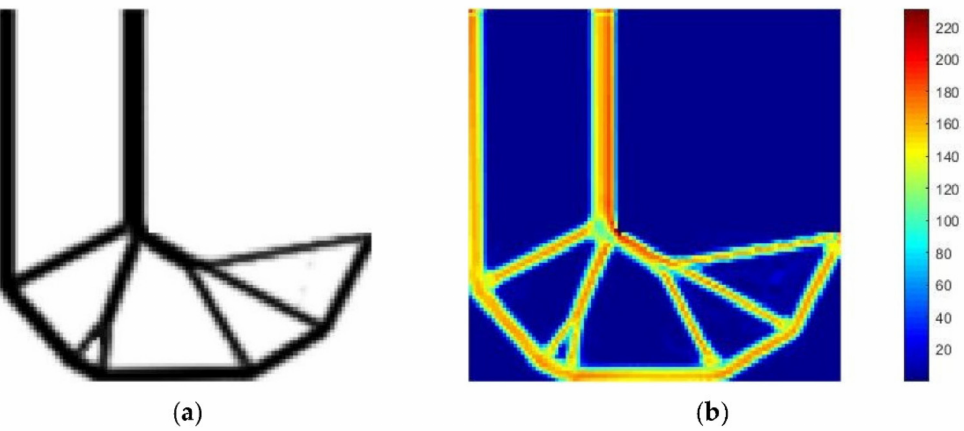
Figure 7. Deterministic topology optimization result of L-beam structure (14,400 elements): ( a ) Topo- logical structure; ( b ) Von Mises stress distribution.